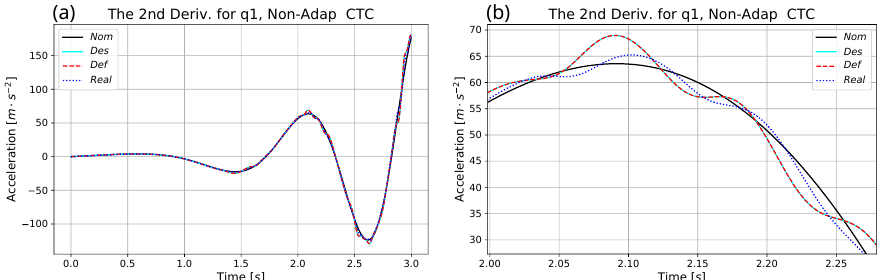
Figure 14. Second time derivatives for q 1 ( a ) and the zoomed-in excerpts ( b ) for the non-adaptive CTC controller using the identified